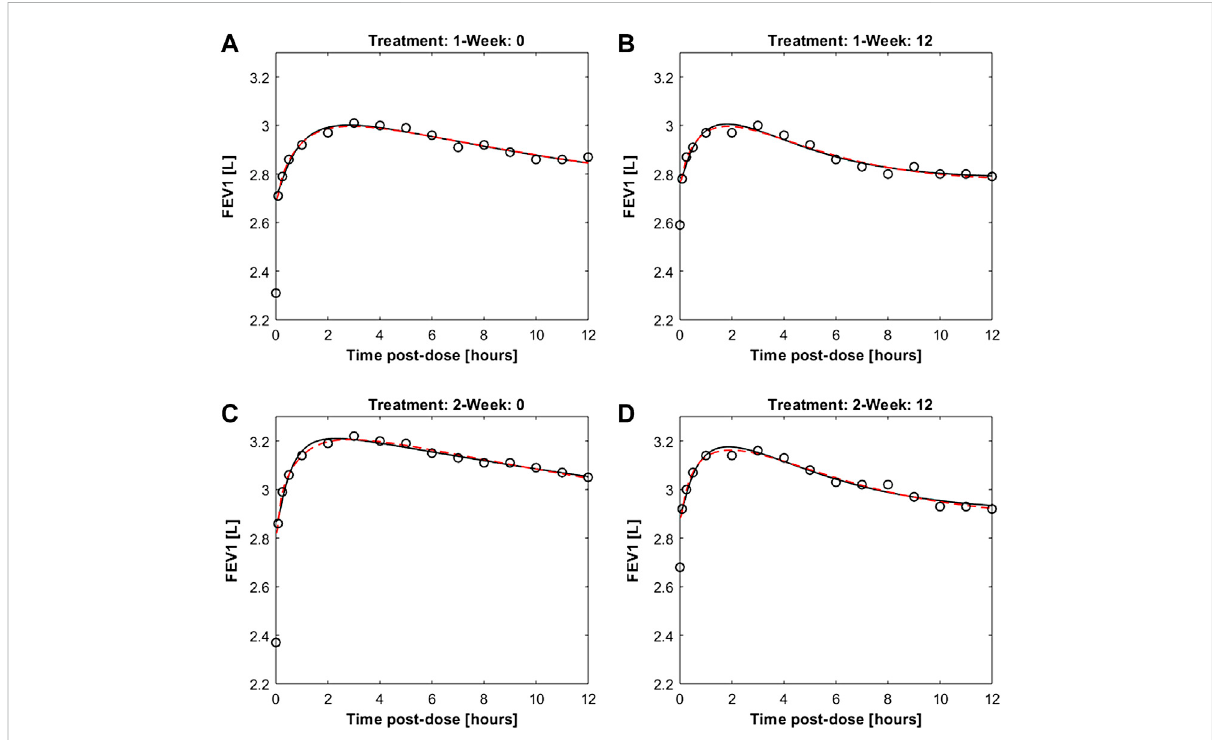
FIGURE 4 Panels (A,B) reportobservedandpredictedmeanFEV 1 onthe fi rstdayandatweek12ofdouble-blindtreatmentwithformoterol12 μ gdelivered via Aerolizer respectively; panels (C,D) report instead observed and predicted mean FEV formoterol 24 μ g respectively.